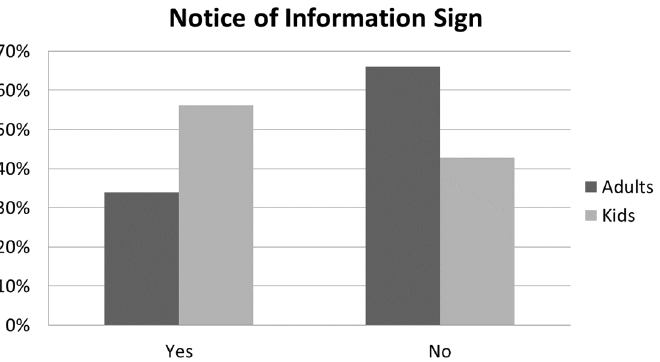
Figure 8. Number of information signs at the Wurstbachtobel monitoring site, Grünten, Bavaria, Germany, based on periods with in-depth analysis of data (12,008 passersby).